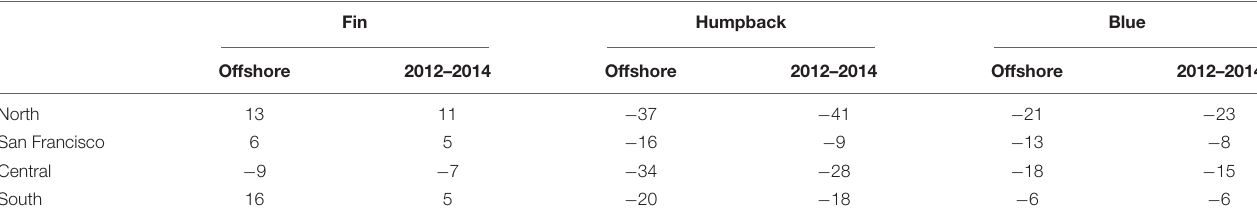
Negative values indicate a decrease in mean risk from the offshore traffic scenario or 2012–2104